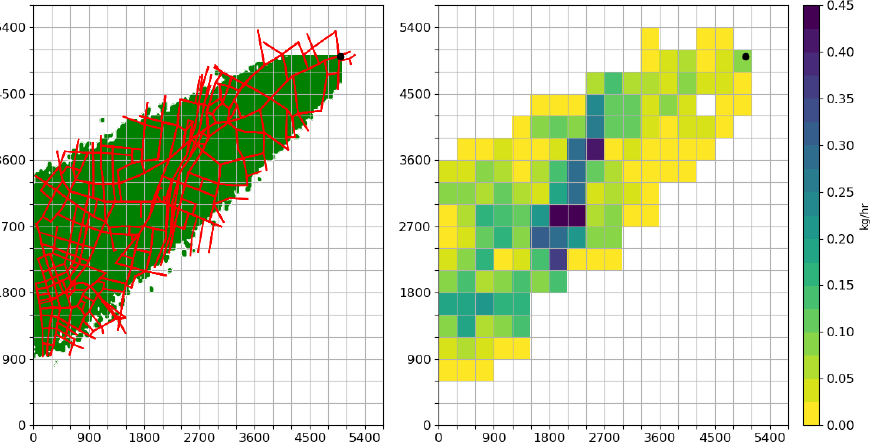
Figure 4. Left panel : the non-zero (footprint) part of the Backward dispersion map, starts from the second POI (case 3), is shown in green. This area represent all the relevant part of space which may contributes to the concentration at the POI (located at ( 5000,5000 ) in this map). All the relevant routes contained within are shown by red lines. Right panel : The area source map, constructed by summing all the routes within every cell.